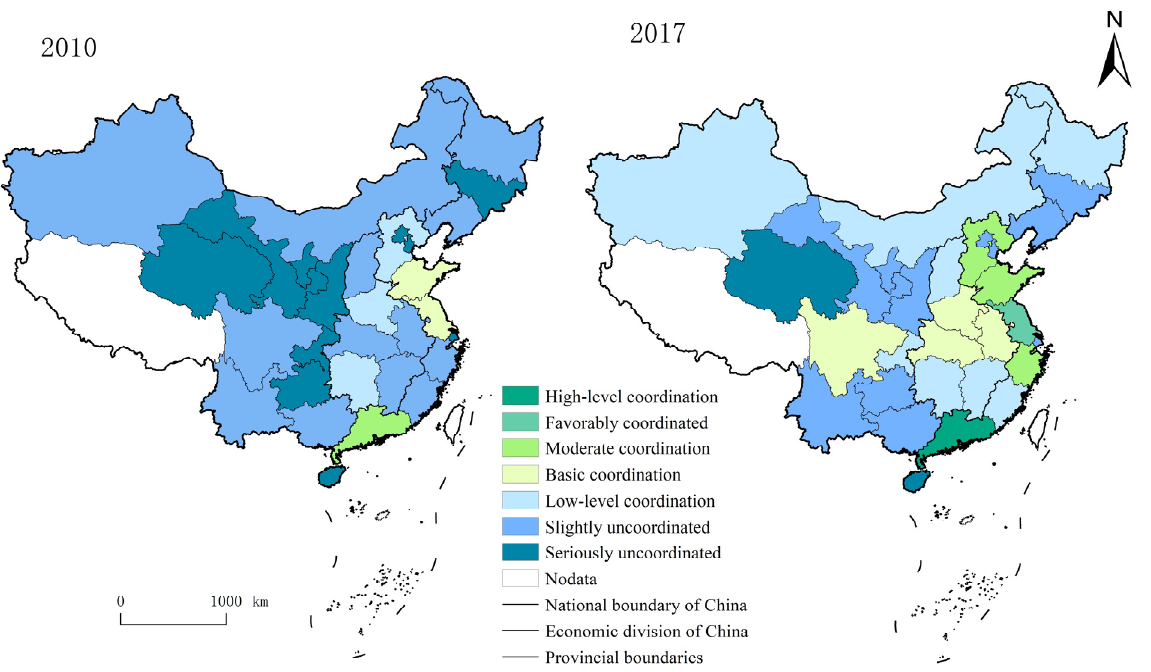
Figure 8. Spatial distribution of the coupling coordination degree of green finance and ecosystem service demand in China from 2010 to 2017.